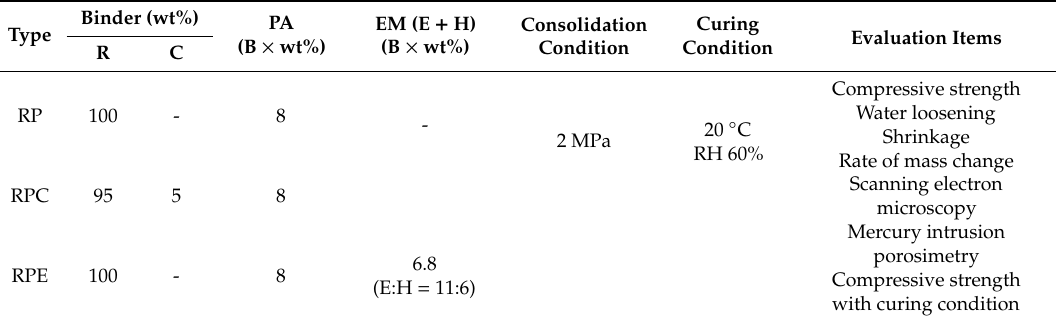
Table 4. Experimental